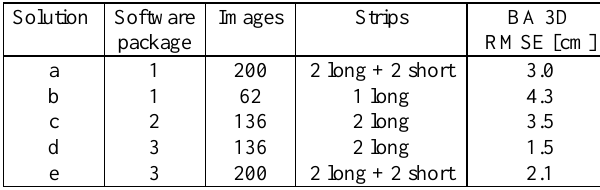
Table 2. Sample results of image bundle block